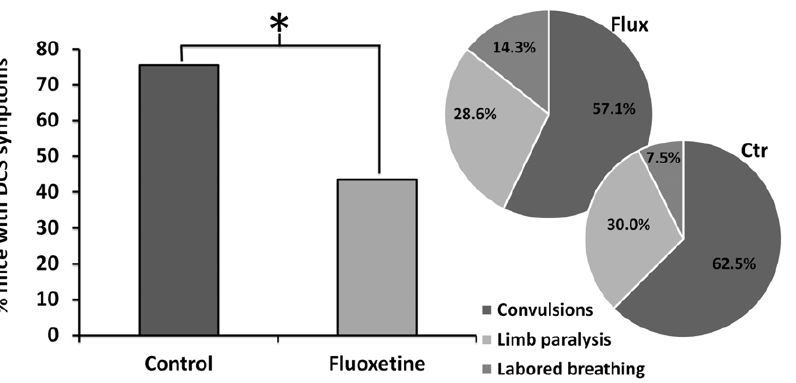
Figure 2. Percents of symptomatic mice suffering from decompression sickness (DCS) within 30 min after surfacing. Histogram in dark grey represents the mice treated with fluoxetine and light grey represents the controls. *denotes p , 0.05 between groups. Distribution of symptoms is represented for each group.